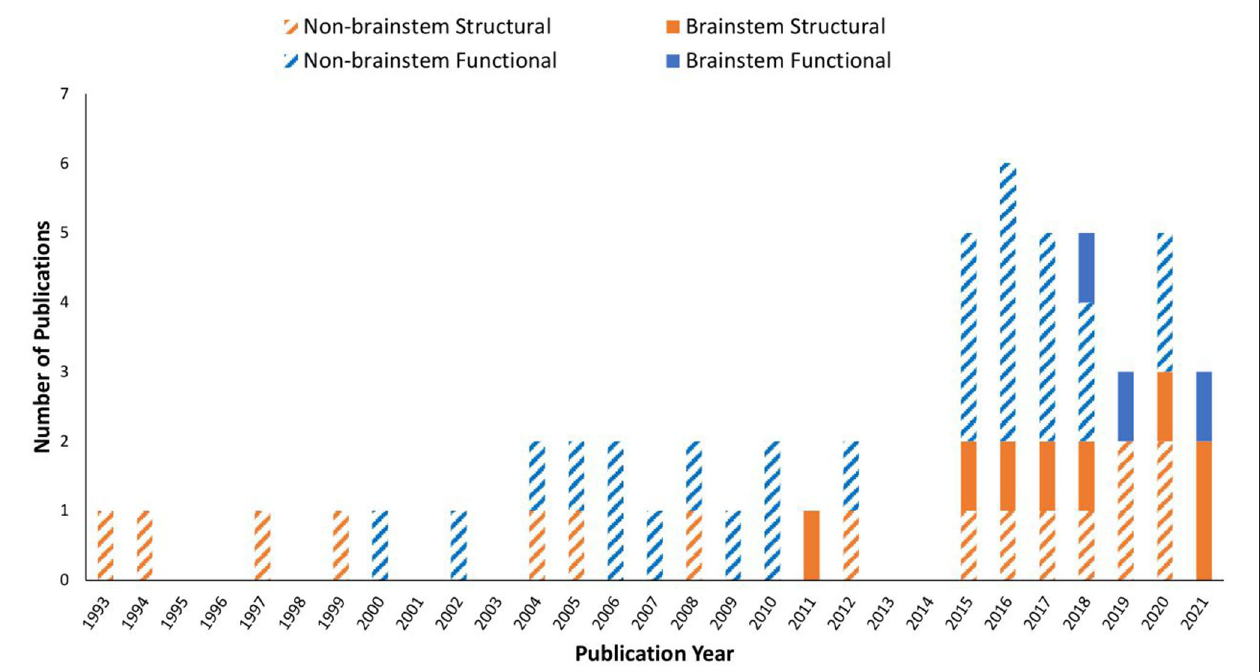
FIGURE 2 | Publication trend in brain MRI research on myalgic encephalomyelitis/chronic fatigue syndrome (ME/CFS) from 1993 to 2021. A MEDLINE and PubMed search using the keywords described yielded a total of 53 MRI original research papers. Studies investigated the brainstem are shown in filled colors, while those excluded the brainstem are in striped colors: orange: structural MRI only; blue: functional MRI